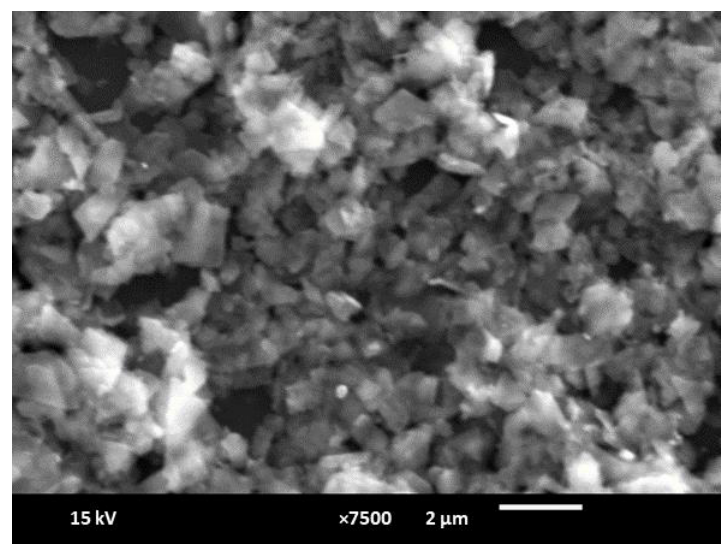
Figure 6. SEM image of MoS 2 nanosheets (scale: 2 µm).